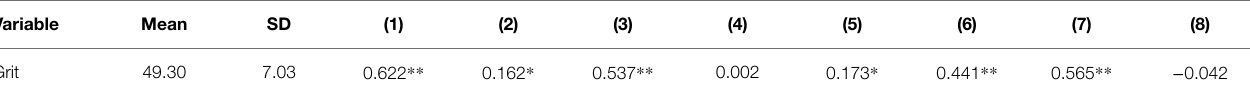
TABLE 2 | Correlation analysis among study variables. Variable